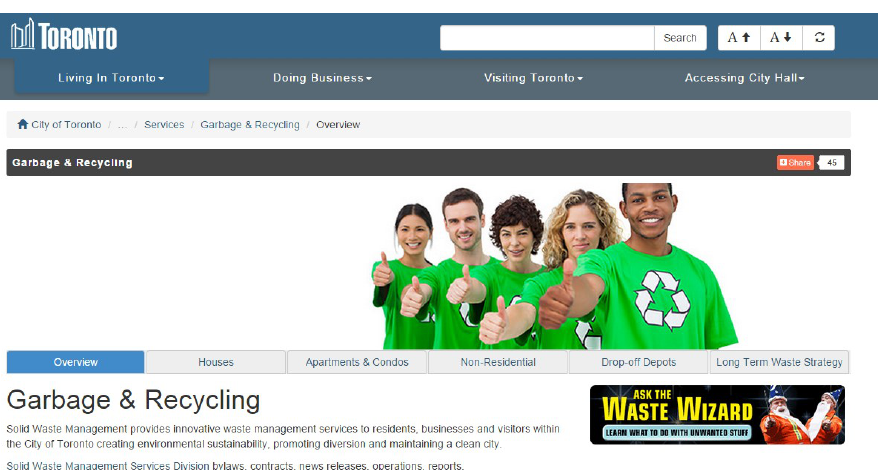
Figure 16. Sample Web Page #3 (City of Toronto).